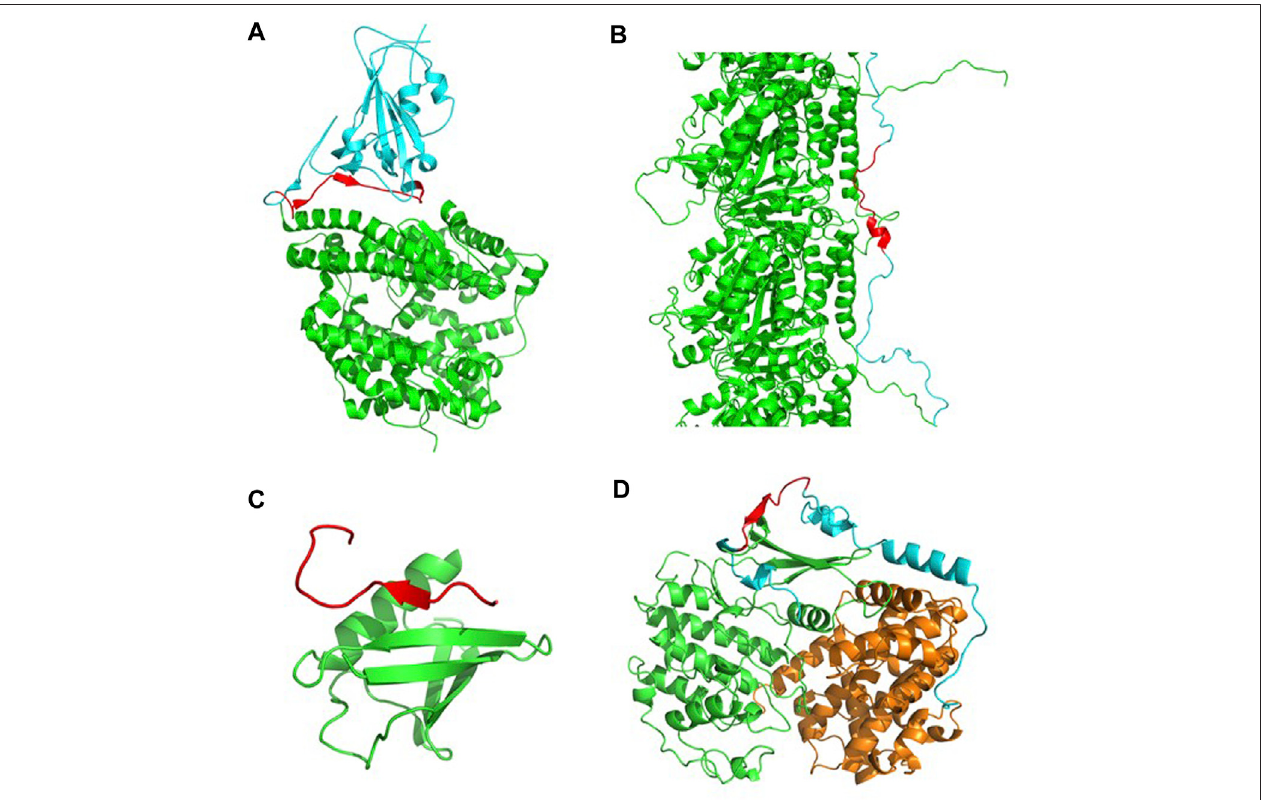
FIGURE 4 | Identi fi cation of LIPs mediating PPIs selected from the CARs-DB. (A) The RBD of the SARS-CoV-2 spike protein (in cyan) in complex with its ACE2 receptor (in green) (PDB: 6LZG). In the interface, a 22-aa long CAR (in red) is found as a LIP that facilitates the recognition and entrance of the virus into the cell. (B) A segment of the tau-F isoform (in cyan) associated with tubulin-alpha-1B chain (in green) (PDB: 7PQP). A short CAR of 13 residues (in red) with an alpha-helix mediates functionalinteractionsinthe structural ensemble. (C) SIM-PIAS2 incomplexwithSUMO-1 (in green) (PDB:2ASQ). ACARof16 residues withalocal beta-sheet (in red) forms a SUMO-interaction motif that overlaps at functional interaction sites. (D) The p27 protein (in cyan) in complex with cyclin-dependent kinase 2 (in green) and cyclin A (in orange) (PDB: 1JSU). A polar CAR of 12 residues (in red) is found within an IDR that folds upon